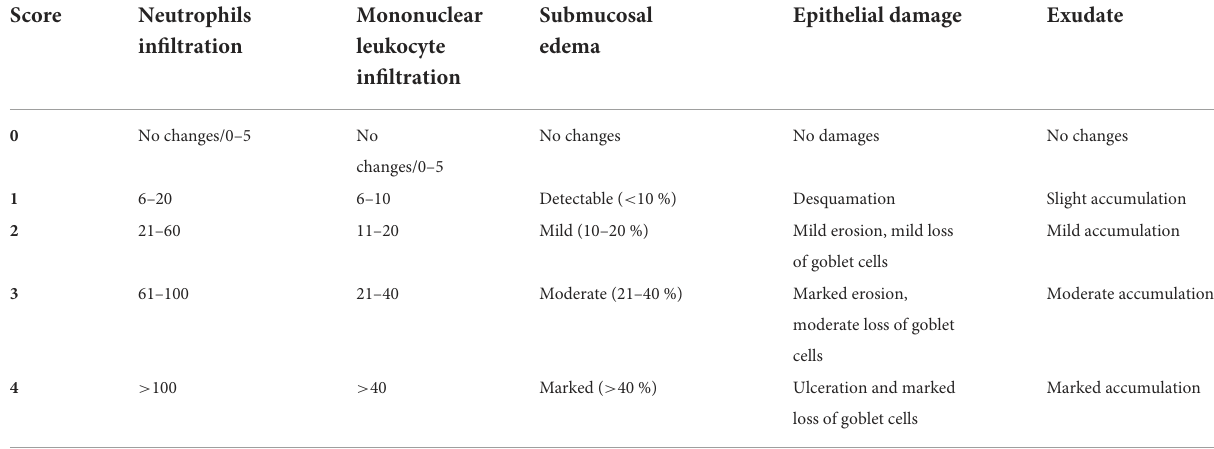
TABLE 1 Histopathology score criteria (Sarichai et al.,